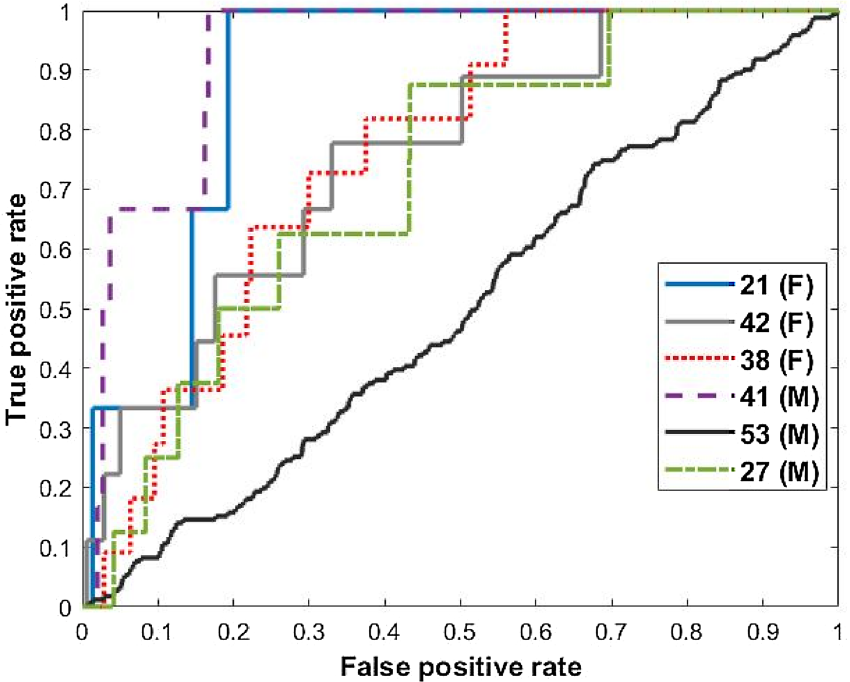
Figure 2. The receiver operating characteristic (ROC) curve for ambulatory patients (Table 2). Five of six patients analyzed achieved seizure forecasts significantly more accurate than a chance predictor, with mean AUC-ROC of 0.80 (range